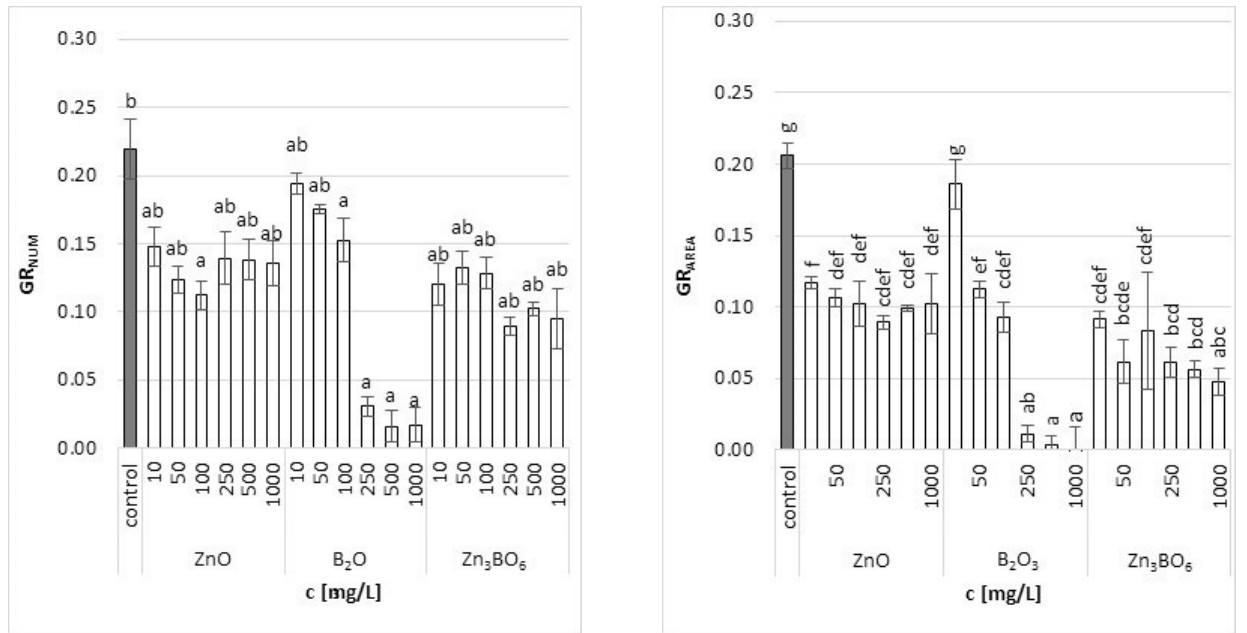
Figure 1. The relative growth rate of L. minor plants (based on counted frond number GR NUM and frond area GR AREA ) after 7 days of growth in the solutions supplemented with ZnO, B 2 O 3 or Zn 3 BO 6 , respectively, at concentrations of 10, 50, 100, 250, 500 and 1000 mg/L. Control plants were grown in Steinberg solution; standard deviation is represented as ± S.D. ( n = 3), and two-way ANOVA test with Dunnett’s multiple comparisons was applied. The average growth rate was calculated as the slope of the logarithmic growth curve. Table 1. The inhibition of growth of L. minor plants (based on counted frond number and frond area) after 7 days of growth in the solutions supplemented with ZnO, B 2 O 3 or Zn 3 BO 6 at concentrations of 10, 50, 100, 250, 500 and 1000 mg/L. Control plants grew in Steinberg solution; standard deviation was represented as ± S.D. ( n = 3), and two-way ANOVA test with Dunnett’s multiple comparisons was